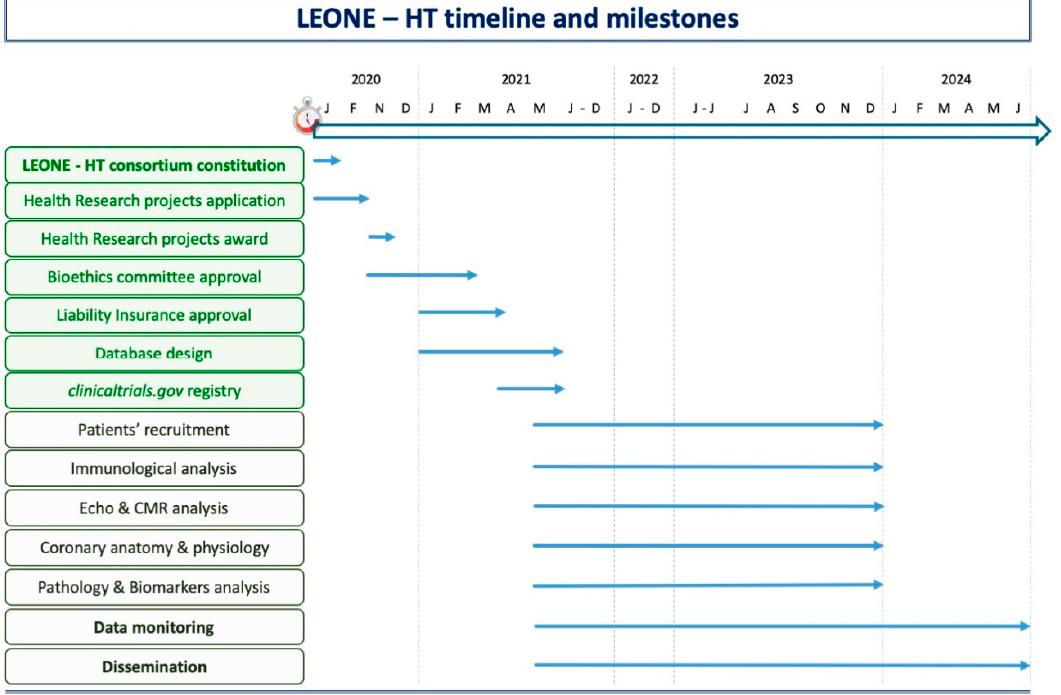
Figure 3. Study timeline and milestones.